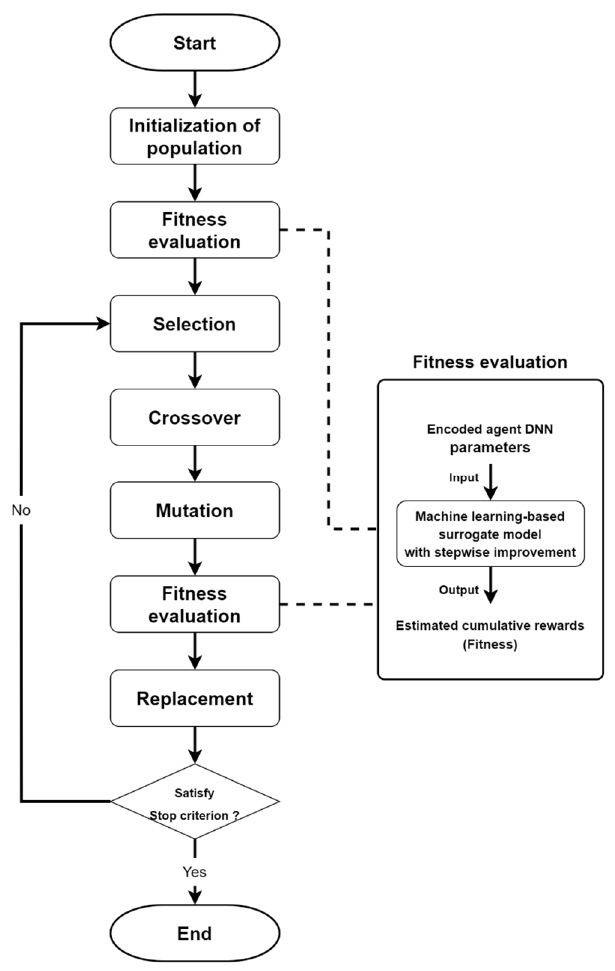
Figure 3. Flowchart of the proposed surrogate-assisted genetic algorithm.